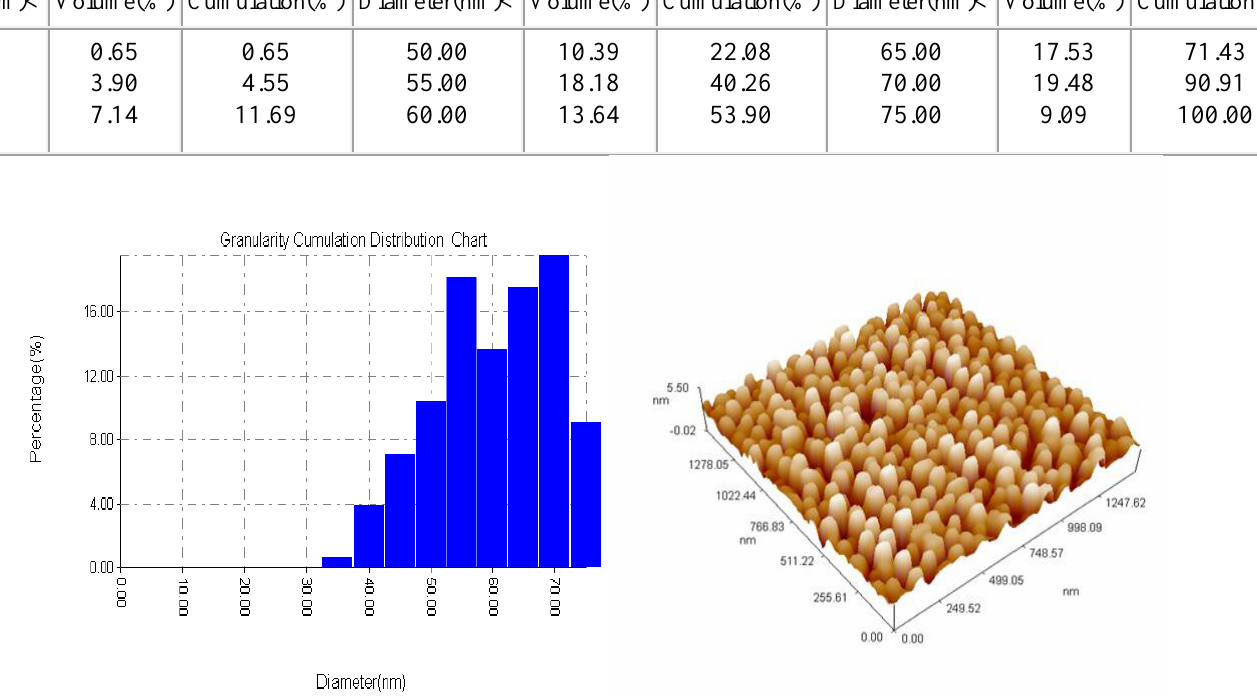
Fig.1: Addition percentage (%) vs. diameter of TiO